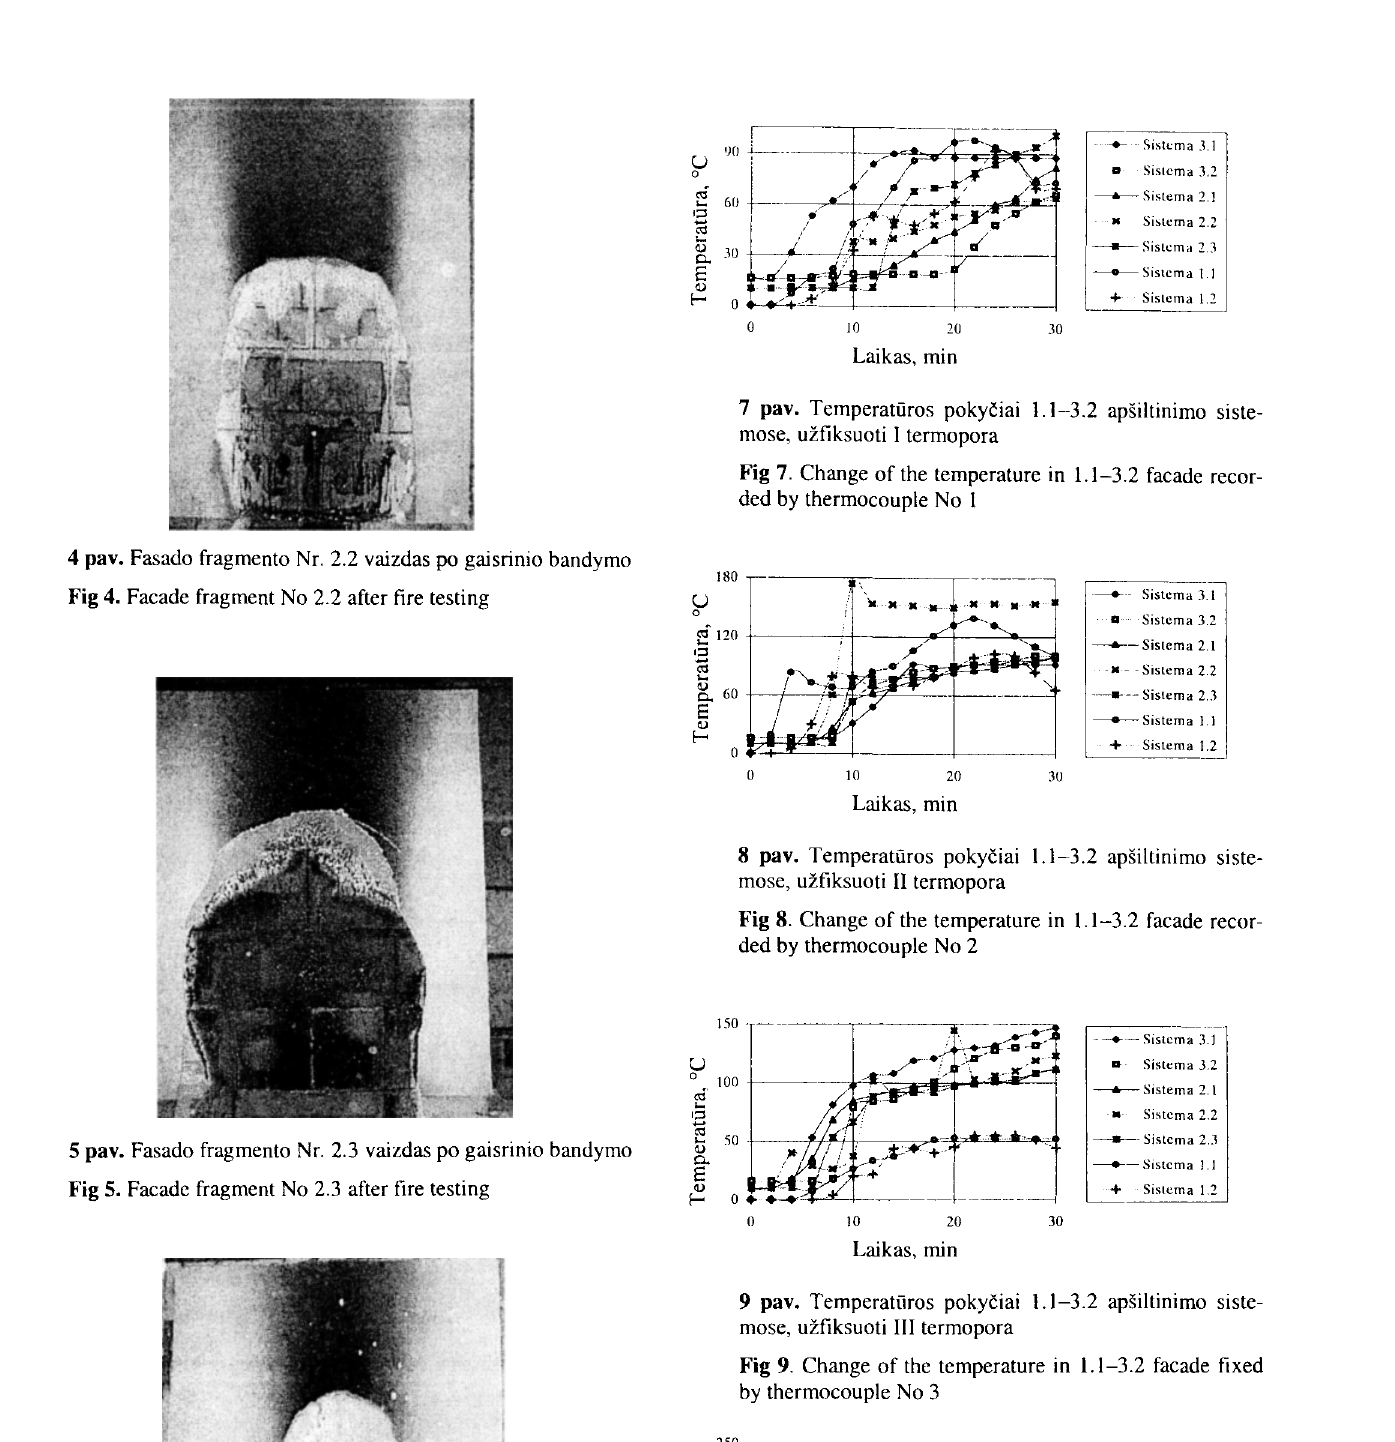
Fig 9. Change of the temperature in 1.1-3.2 facade fixed